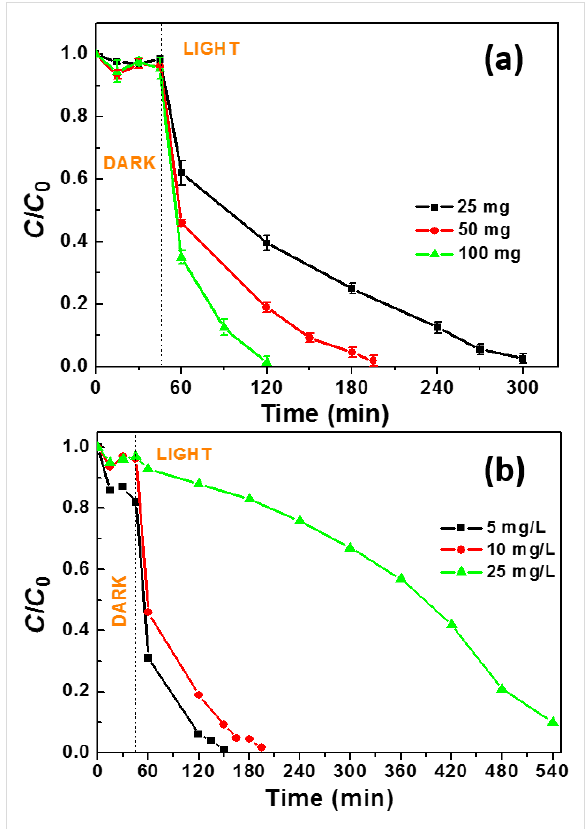
Figure 7: (a) Effect of the catalyst concentration on the photodegra- dation efficiency (25, 50 or 100 mg of photocatalyst were dispersed in 50 mL of a 10 mg/L RhB solution). (b) Influence of RhB concentration on the photocatalytic efficiency (50 mg of photocatalyst and 50 mL of the dye solution were used).